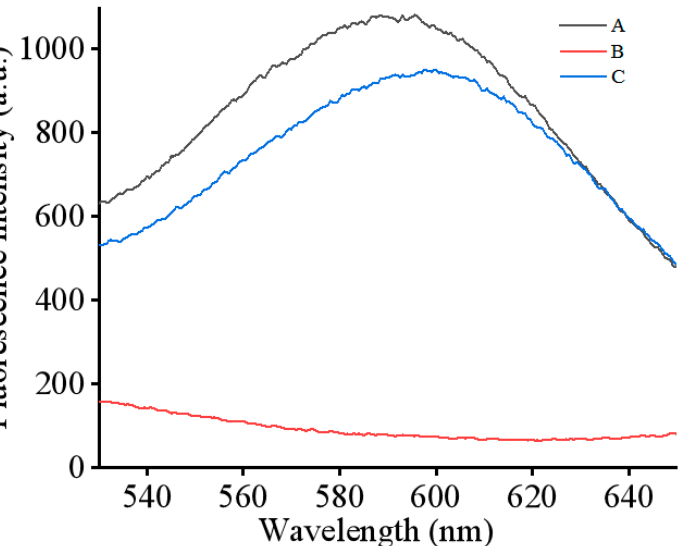
Figure 1. The feasibility of the proposed method. ( A ) Tn + CuSO 4 + Vc; ( B ) Tn + Exo III + Exo I+ CuSO 4 + Vc; ( C ) Tn + SA + Exo III + Exo I+ CuSO 4 + Vc. Concentrations of Tn, SA, Exo III, Exo I, CuSO 4 and Vc were 200 nM, 500 nM, 100 U/mL, 100 U/mL, 100 μ M and 1 mM, respectively.